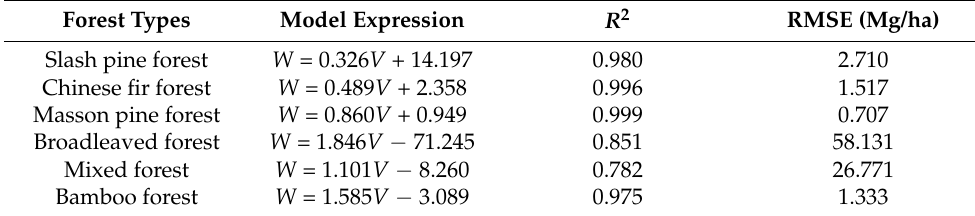
Table 2. Relationships between stand biomass and volume for different forest types. Forest Types Model Expression Slash pine